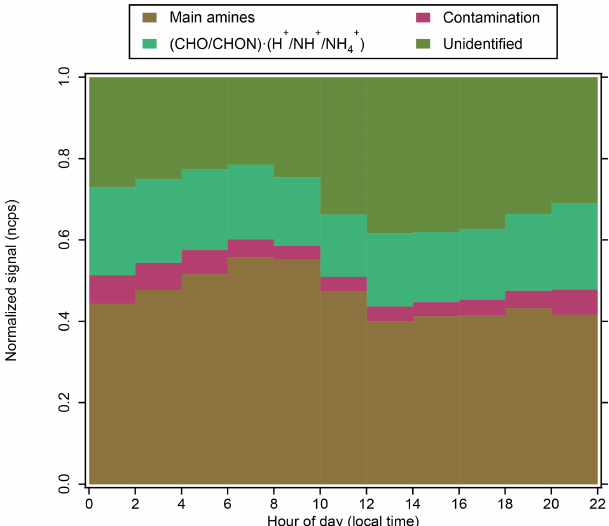
Figure 9. Diurnal variation of positive-ion groups at CHC, aver- aged over measurements in February and March 2018 (when APi- TOF was operating in positive-ion mode; see Sect.